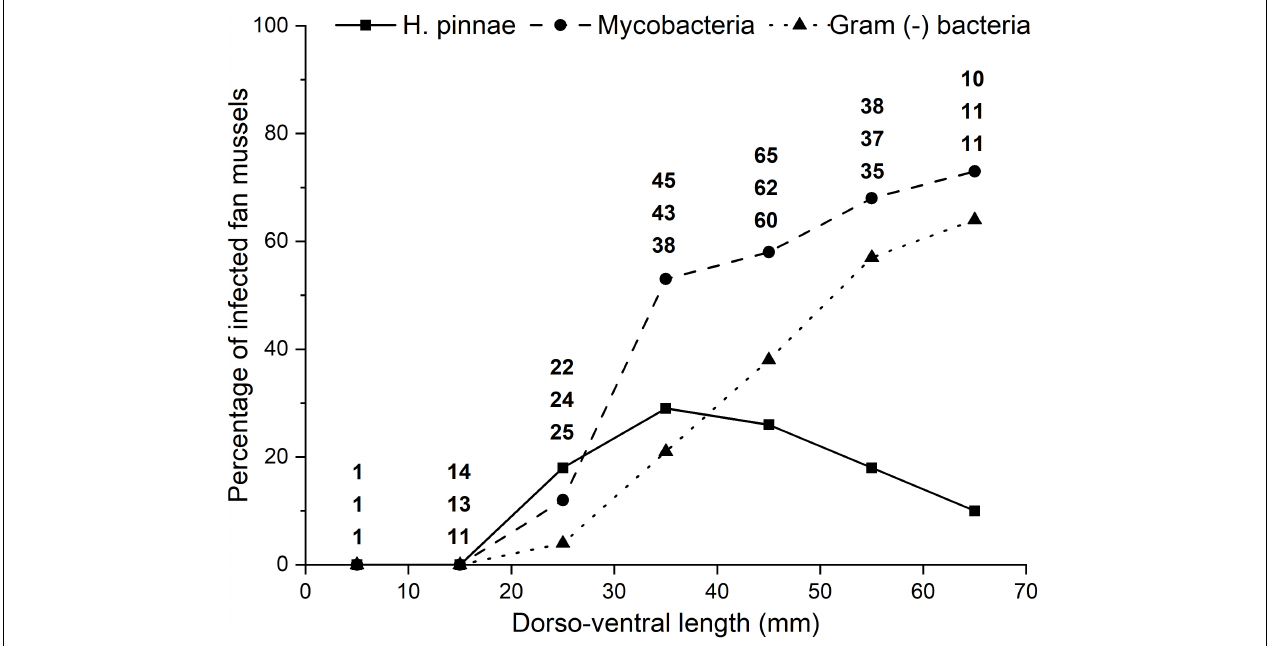
FIGURE 6 | Variation of the percentage of fan mussels found infected by histology with size (dorso-ventral length) classes of the host. Infections with Haplosporidium pinnae , mycobacteria and Gram ( − ) bacteria are distinguished with different line patterns and symbols. The numbers above each size class correspond to the number of fan mussels of that class diagnosed for H. pinnae (top) , mycobacteria (mid) and Gram ( − ) bacteria (bottom) .